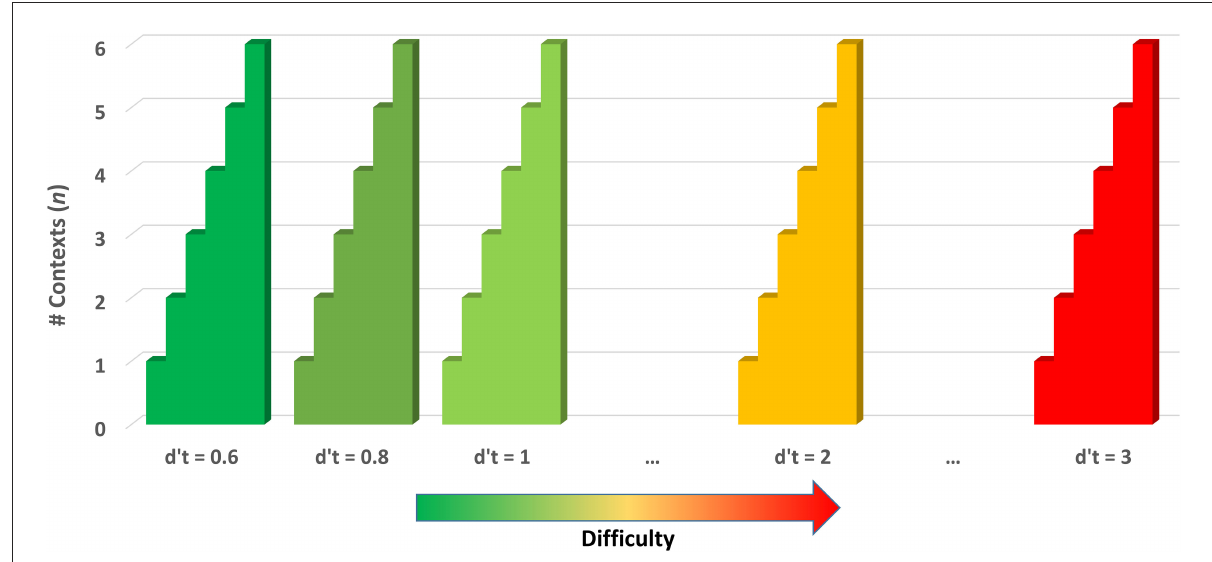
FIGURE2 Depiction of overall difficulty progression by the number of contexts ( n ) and performance threshold ( d’ t ) in the BWGU